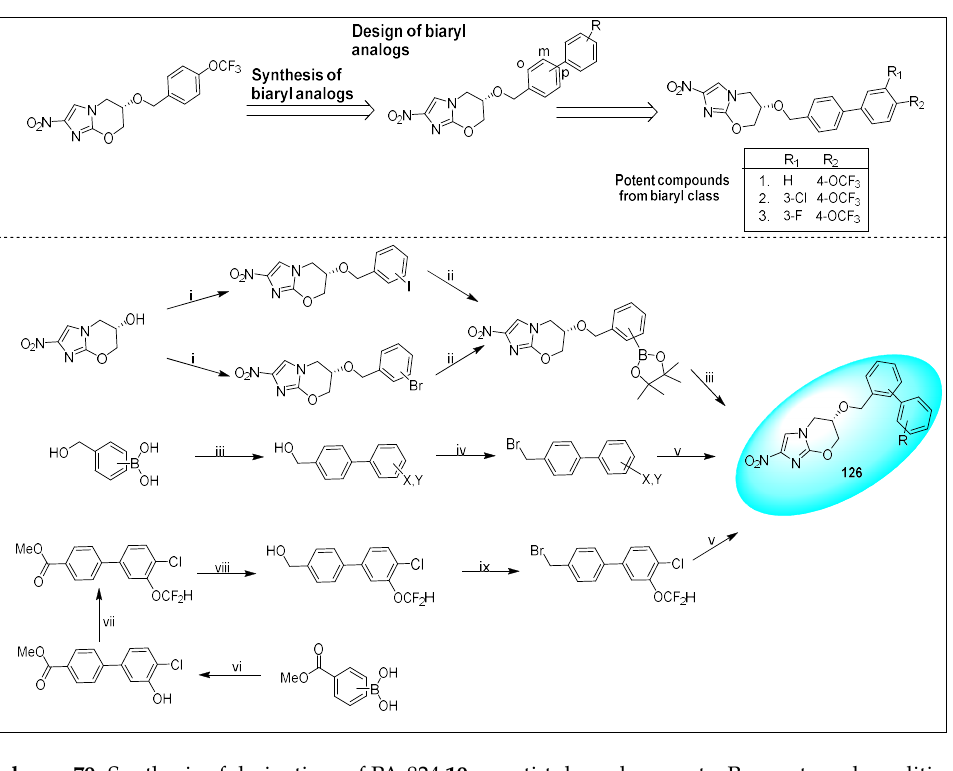
Scheme 79. Synthesis of derivatives of PA-824 19 as anti-tubercular agents. Reagents and condi- tions: ( i ) iodo/bromo benzylhalides, NaH, DMF, 20 °C, 61–97%; ( ii ) ArB(OH) 2 , toluene,